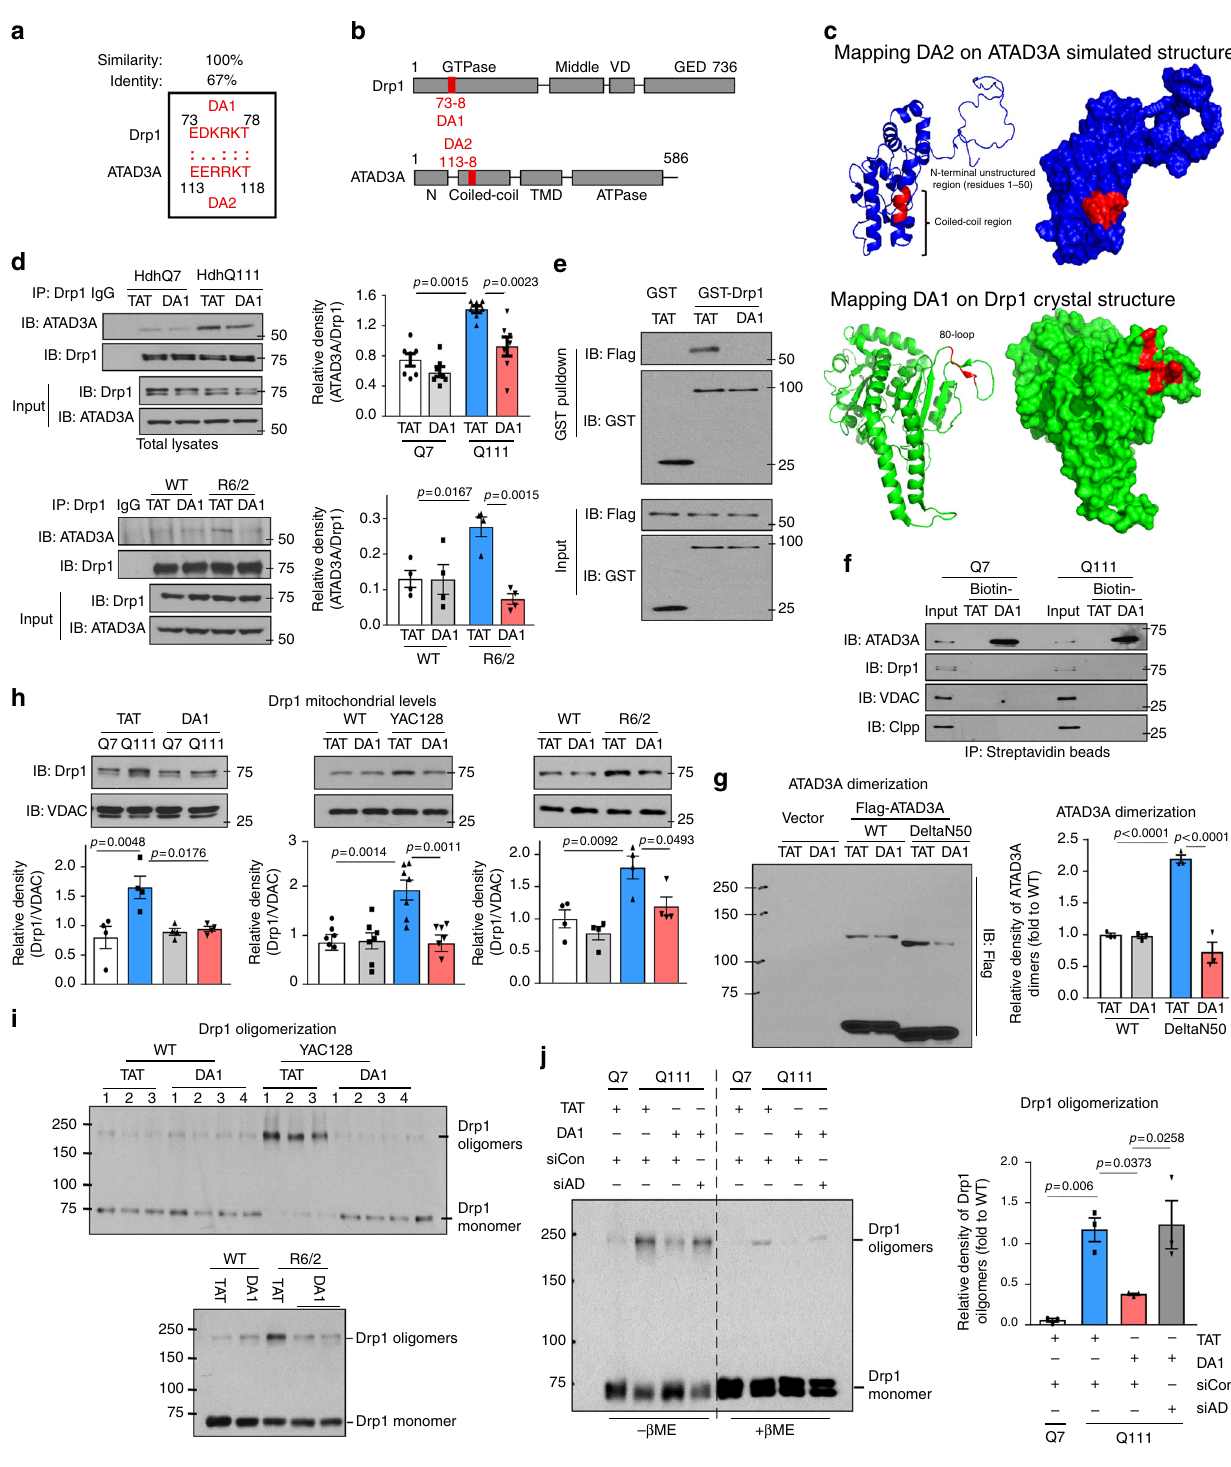
reduced the binding of Drp1/ATAD3A in HdhQ111 cells (Fig. 5d and Supplementary Fig. 7A), in striatal cells exposed to 3-NP (Supplementary Fig. 7B) and in striatal extracts of HD R6/2 mice (Fig. 5d), whereas DA2 showed a trend toward inhibition of the interaction (Supplementary Fig. 7A). Notably, the presence of DA1 abolished the binding of GST-Drp1 and ATAD3A-Flag in vitro (Fig. 5e), indicating a direct inhibition. Peptide DA1 is derived from the loop region of Drp1 GTPase domain,